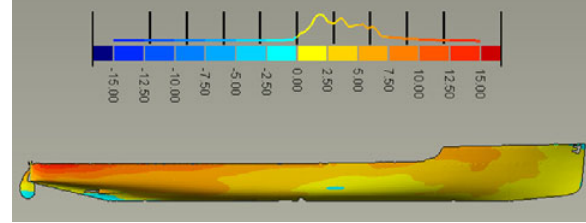
Figure 6: Symmetry analysis of the hull (mm).